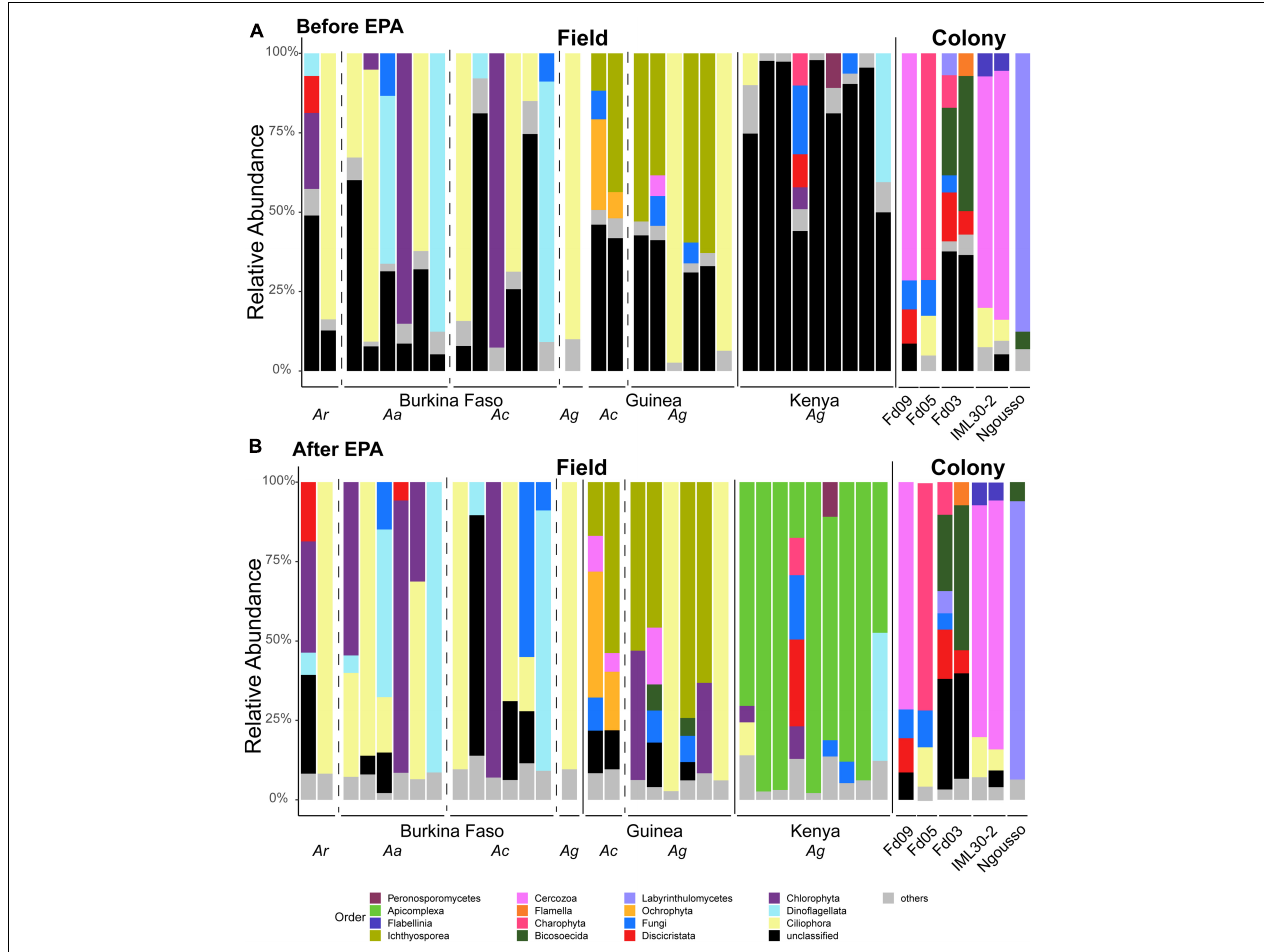
FIGURE 6 | Taxonomic assignments of eukaryotic microbes are improved by employing sequence similarity and phylogenetic placement. Taxonomic Profiles of the micro eukaryotic members of the microbiome before (A) and after (B) application of the Evolutionary Placement Algorithm (EPA). OTUs are called at the Order level. All OTUs present at less than 5% frequency are grouped together and classified as others. Sequences for which there was not a Silva database match are termed unclassified. Each bar represents the micro eukaryotic taxonomic composition of one pool of larval samples from a given country or laboratory colony. Dashed vertical lines separate samples of different mosquito species ( Ar , Anopheles rufipes ; Ac , Anopheles coluzzii ; Ag , Anopheles gambiae ) and solid lines separate samples from different countries and = samples from the field from those from laboratory colonies. All colonies yielding eukaryotic microbes after rarefaction are A. coluzzii